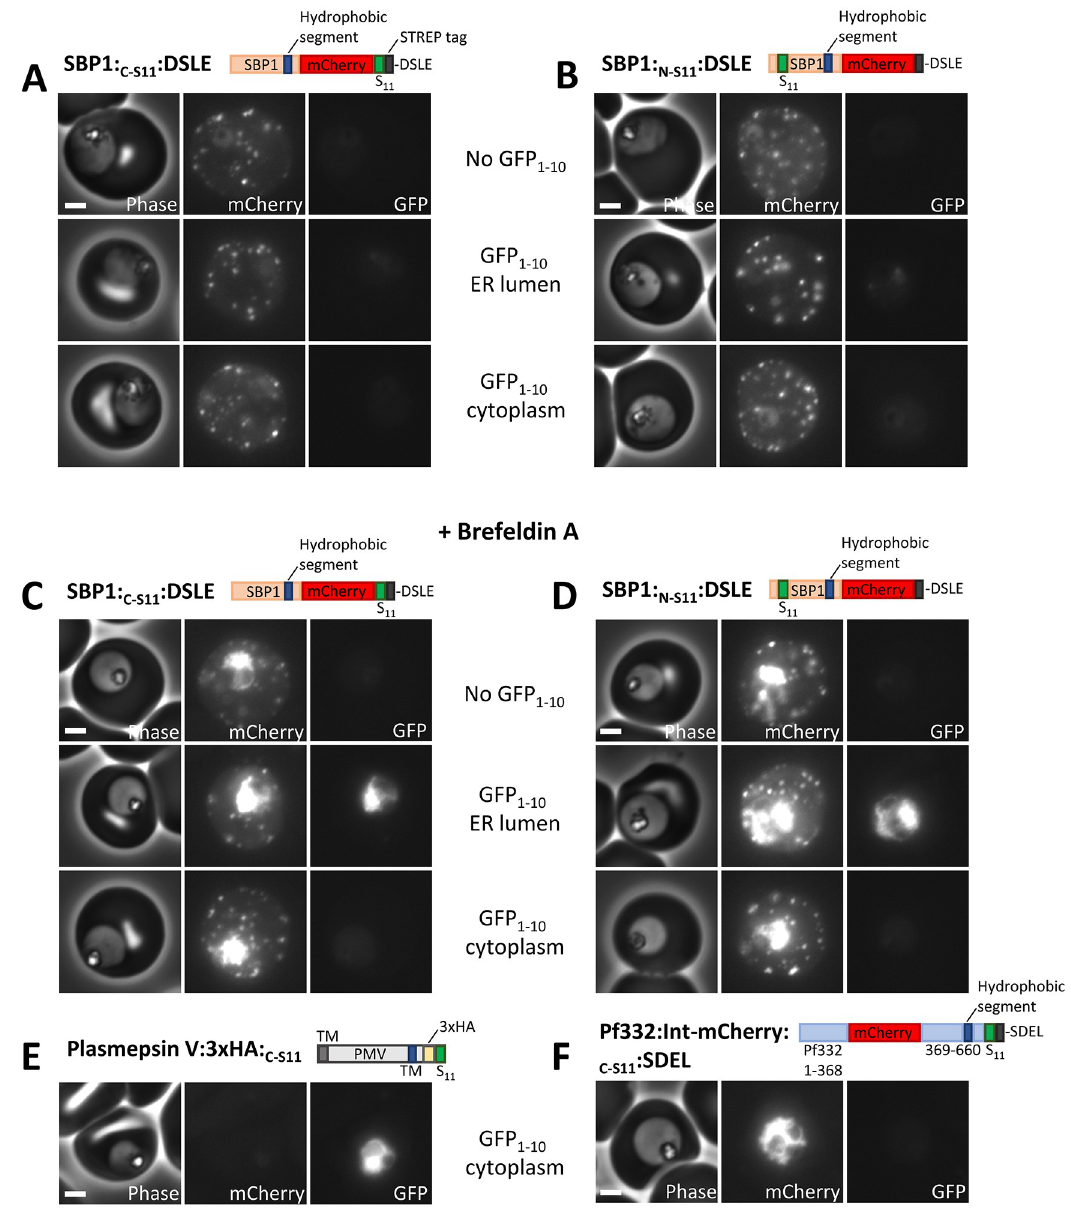
Fig 4. ER-lumenal location of SBP1 in Brefeldin A-treated parasites. (A-B) Phase contrast and fluorescence images of parasites expressing the indicated proteins are shown. Proteins were expressed alone, co-expressed with ER-lumenal GFP 1-10 or cytoplasmic GFP 1-10 , as indicated. (C-F) Phase contrast and fluorescence images of Brefeldin A-treated parasites expressing the indicated proteins. Proteins were expressed alone, co-expressed with ER-lumenal GFP 1-10 or cytoplasmic GFP 1-10 , as indicated. Parasites were treated with 1 μ g/ml Brefeldin A for four hours prior to imaging. Scale bar: 2 μ m. In order to trap SBP1 in the parasite ER, cultures were treated for four hours with 1 μ g/ml of Brefeldin A. While this does not completely block protein export, it is sufficient to cause detectable accumulation of SBP1 protein within the parasite (Figs 4C and 4D). The protein accumulated within the parasite colocalised with the ER-marker plasmepsin V (S5D Fig). Treatment with DMSO alone did not lead to ER-accumulation of SBP1 (S5E Fig). In Brefeldin